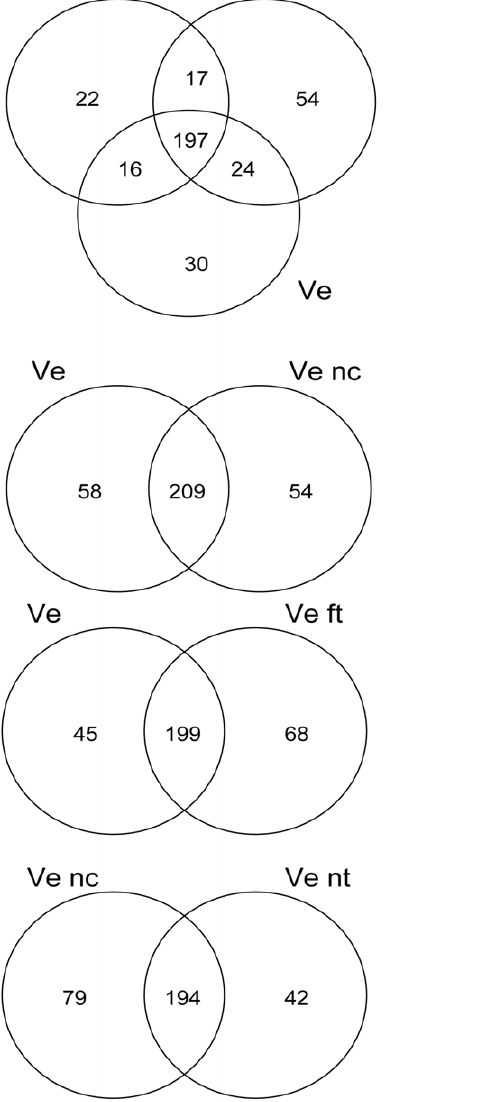
Figure 3. Common and exclusive SNCs in the Pa, Vi and Ve samples and paired samples from native and